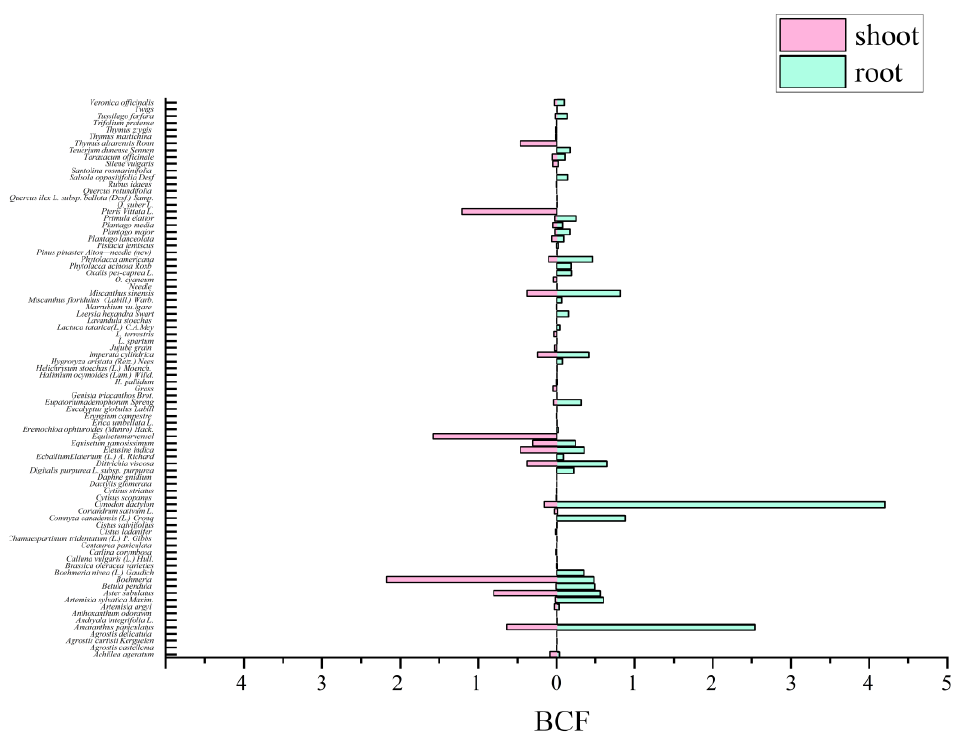
the Figure 7. The ratio between the concentration of Sb in the root/shoot of plant and that present in the soil.